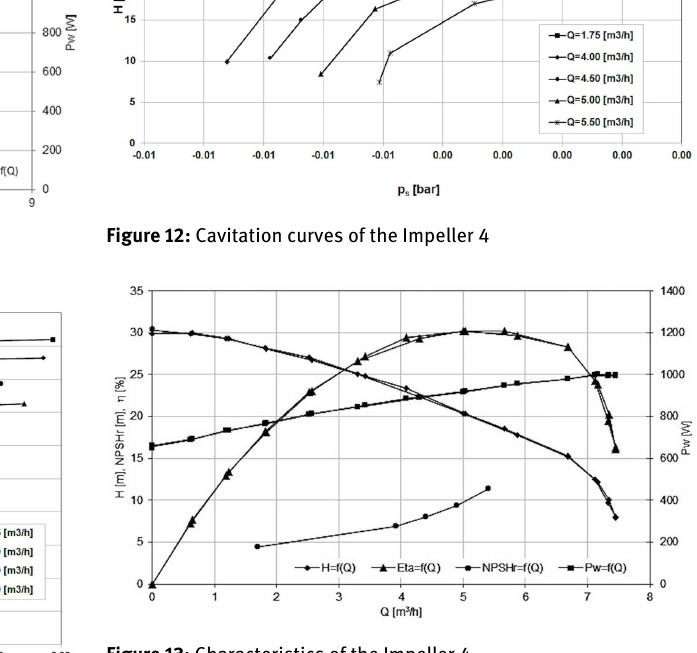
Figure 13: Characteristics of the Impeller